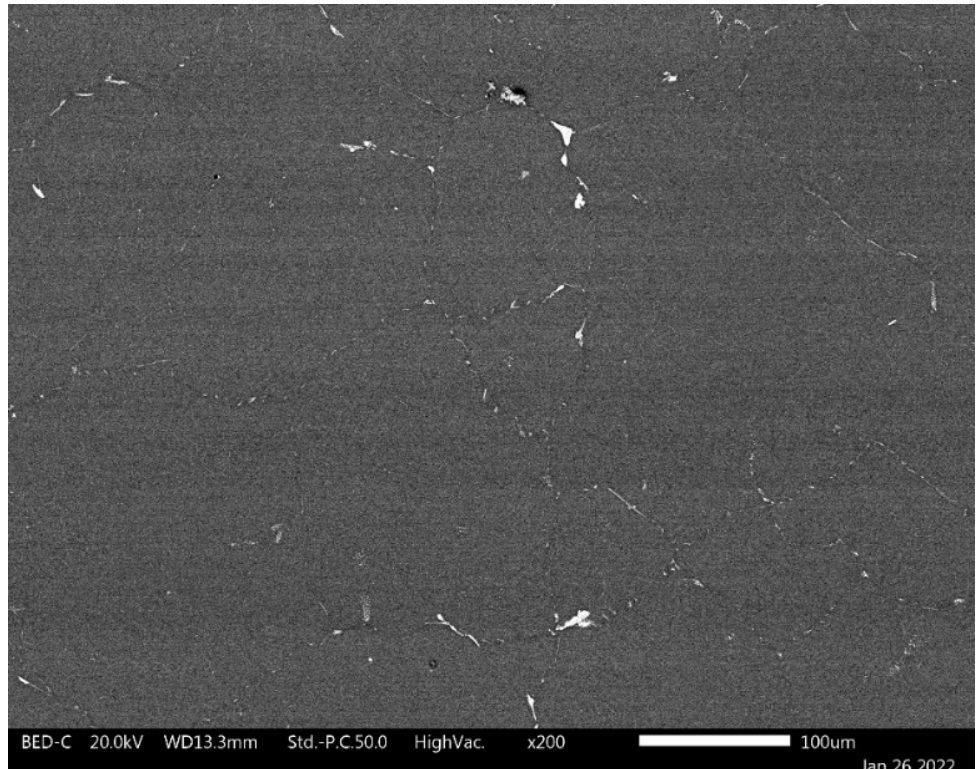
Figure 5. The homogenized microstructure of 2A97.